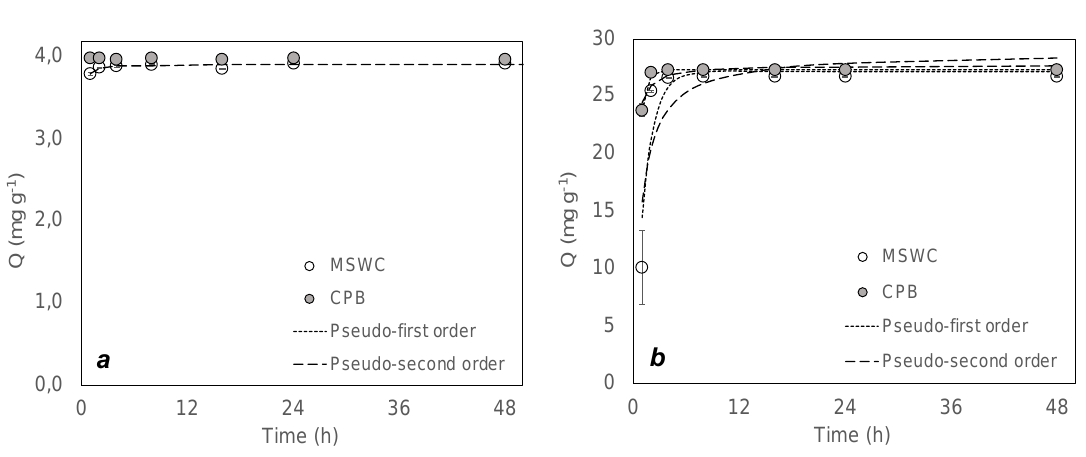
Figure 2. Kinetics of adsorption municipal solid waste compost (MSWC) and composted pine bark (CPB) at ( a ) 1:20 solid:liquid ratio and ( b ) 1:100 solid:liquid ratio. Bars show standard deviation of the mean (n = 3).